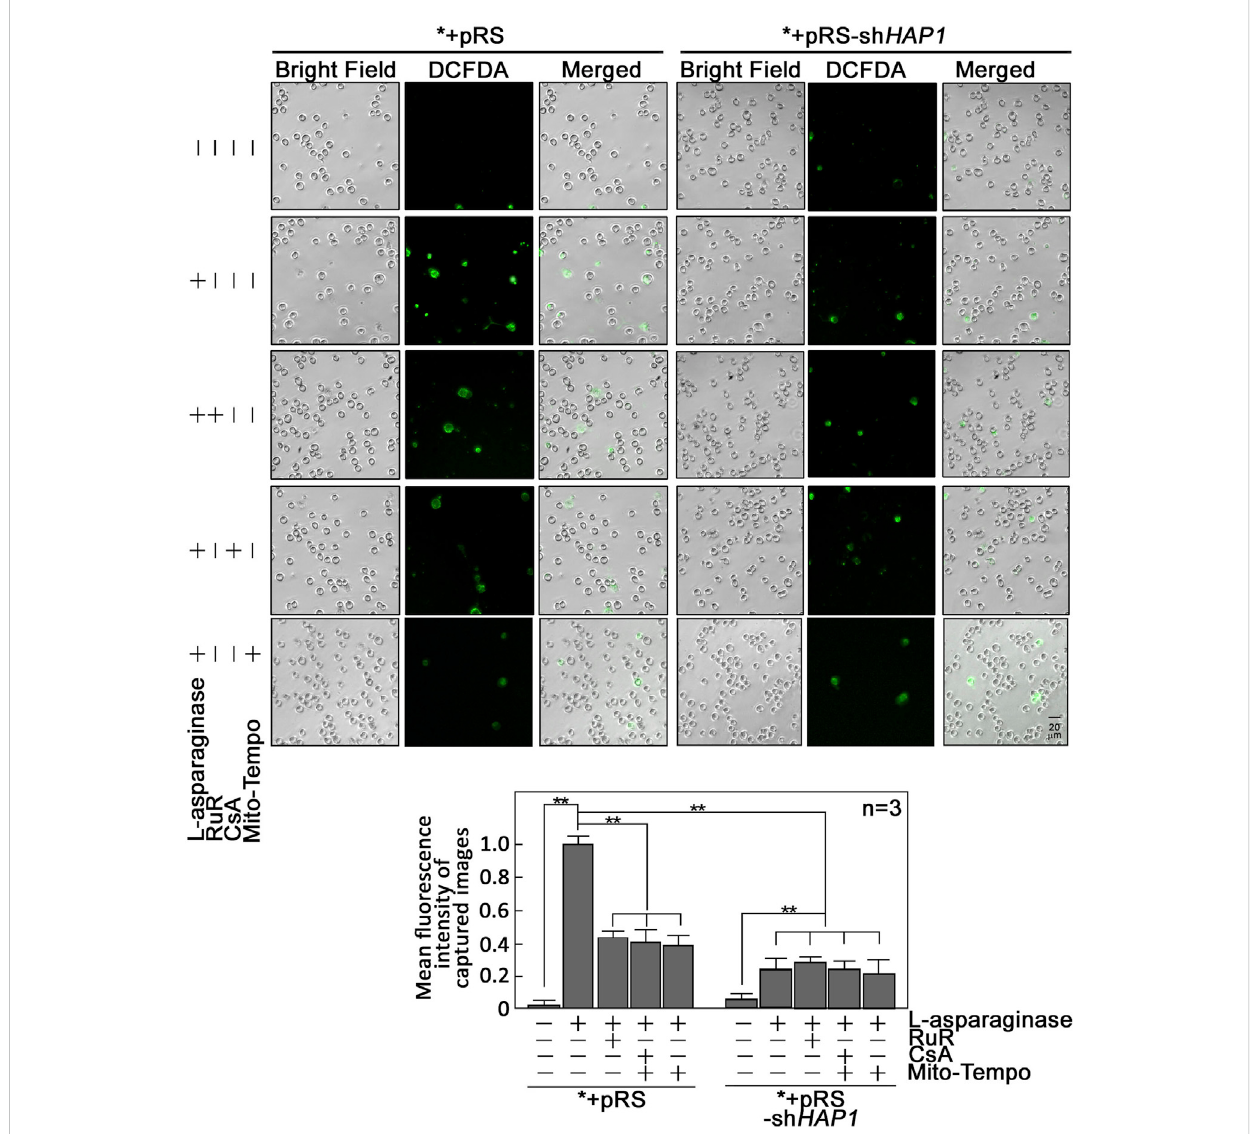
FIGURE 5 L-asparaginase causes an increase in cytoplasmic ROS level. *+pRS and *+pRS-sh HAP1 cells pre-treated with XeC, RuR, CsA or Mito-Tempo then treated with L-asparaginase were stained with DCFDA and examined by microscopy. Cell images were acquired using an Olympus 1 × 71 inverted microscope at ×160 magni fi cation. The bar graph shows mean fl uorescence intensity of captured images measured using the ImageJ software with values from cells stimulated with L-asparaginase normalized to 1. Values are means ± SEM from three independent experiments ( n = 3). ** p <